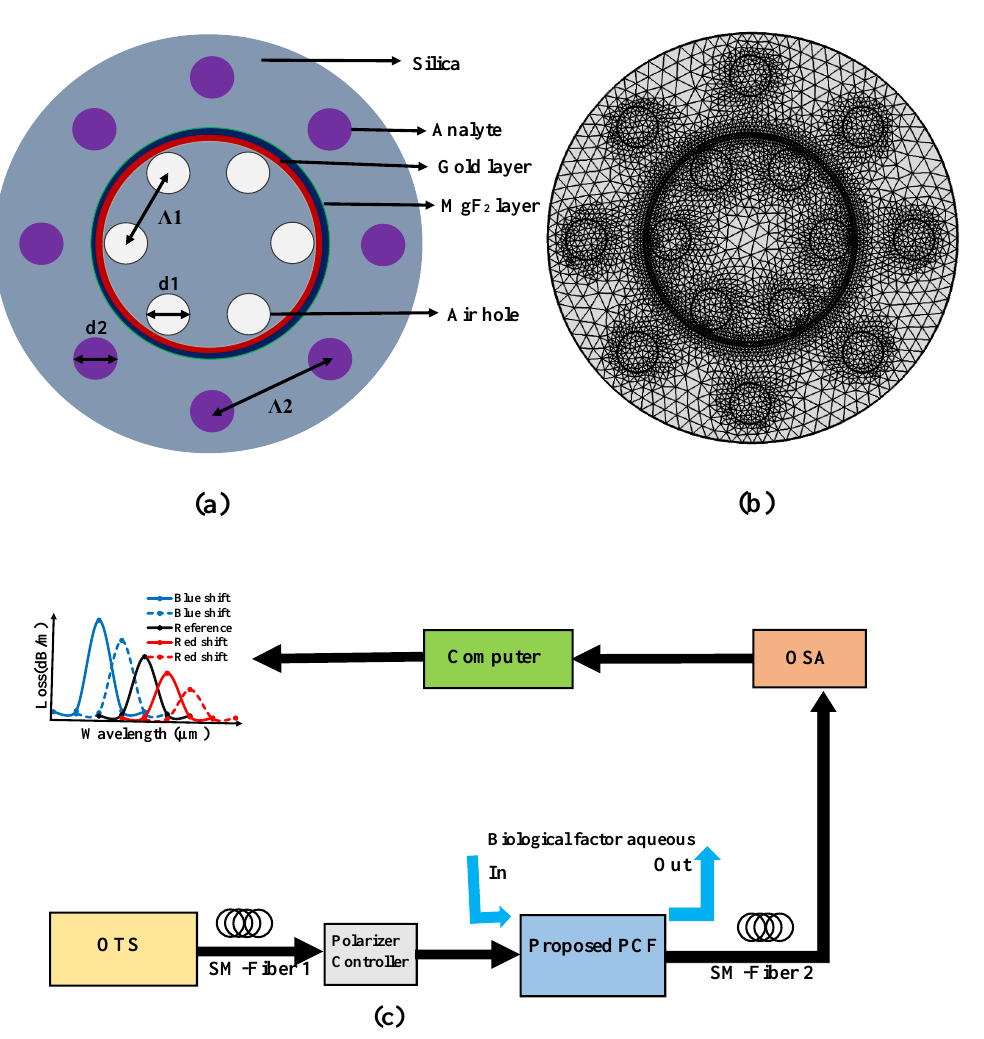
Figure 1. The ( a ) cross-sectional area, ( b ) mesh diagram and ( c ) schematic model of the proposed